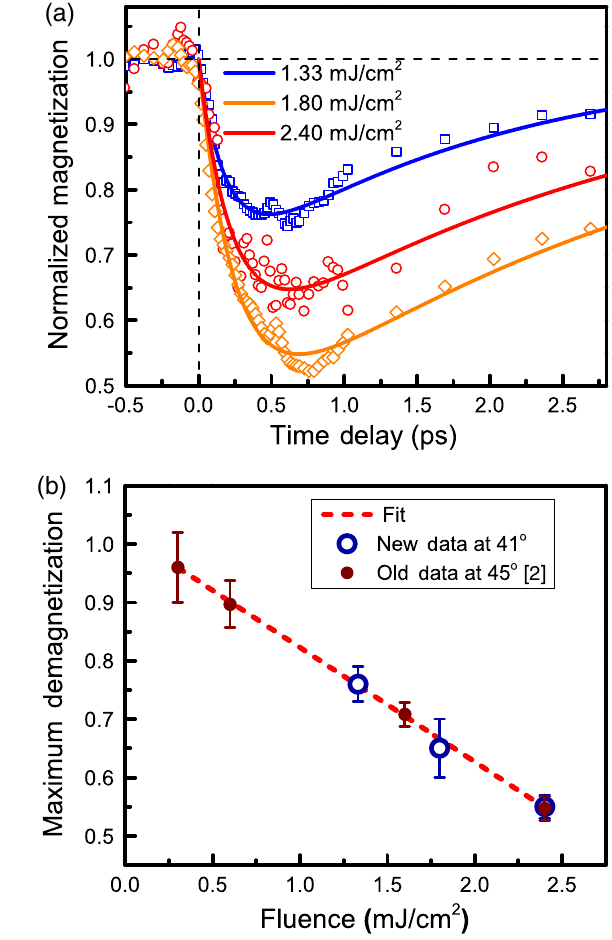
FIG. 2. (a) Demagnetization dynamics measured at a 41 (cid:1) angle of incidence for three different pump fluences. (b) Maximum demagnetization as a function of pump fluence. The red points are the original data from Ref. [2] measured at 45 (cid:1) , while the blue open circles are the new data measured at 41 (cid:1) . The deviation of the new data from the dashed red line, obtained from the original data via linear regression, is used to determine potential artifacts due to a pathological refractive index, which are found to be less than 2% .